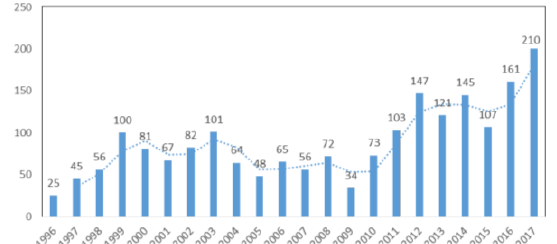
Figure 3 Year wise enrolled participants in CSSTEAP training programmes